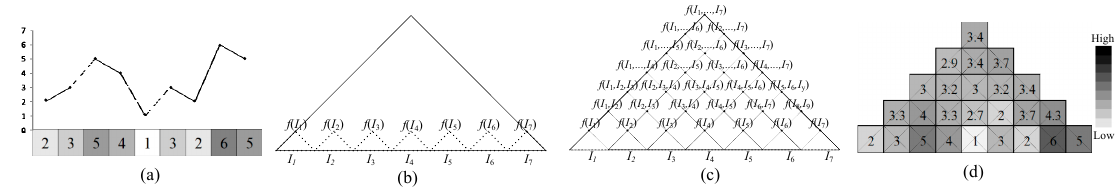
Figure 11. Representing time series in the TM. ( a ) Time series represented in a line chart and color-coded linear raster. ( b ) The TM representation of the base intervals in a time series. ( c ) The TM representation of all intervals in a time series. ( d ) Rasterized TM with grey-coded attributes.